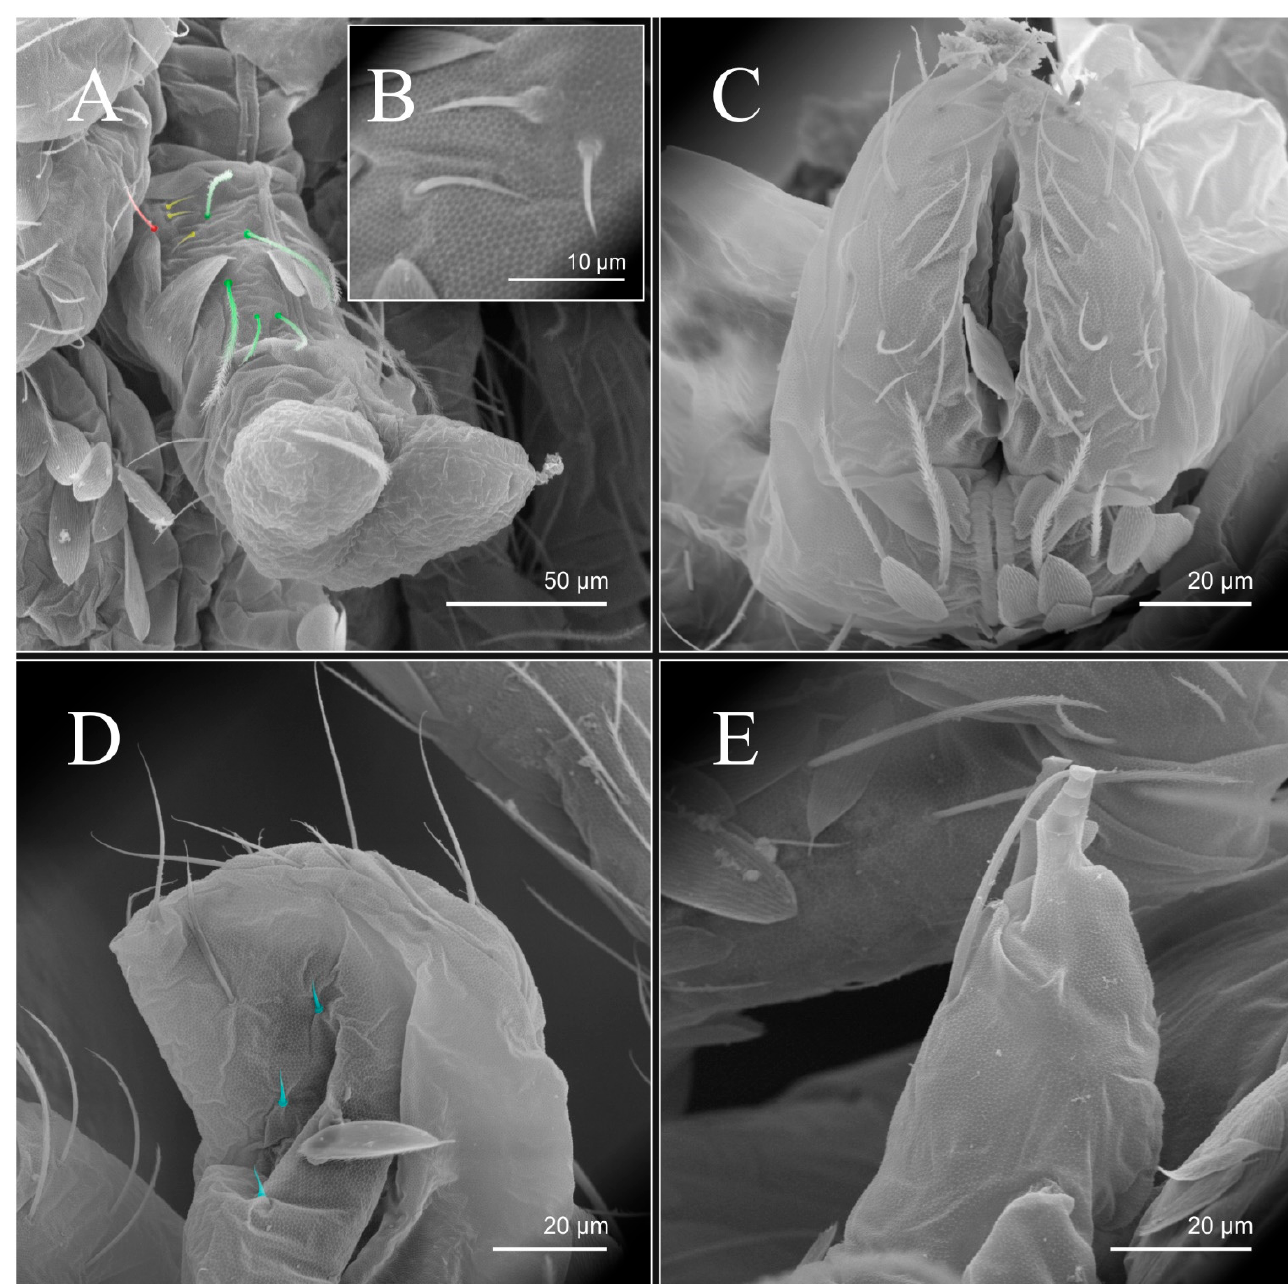
(Figure 13C); distal posterior side with two distal smooth chaetae and three subdistal reduced spines per side (Figure 13D). Tenaculum with one chaeta on the corpus, ramus tenacular with four teeth (Figure 13E).